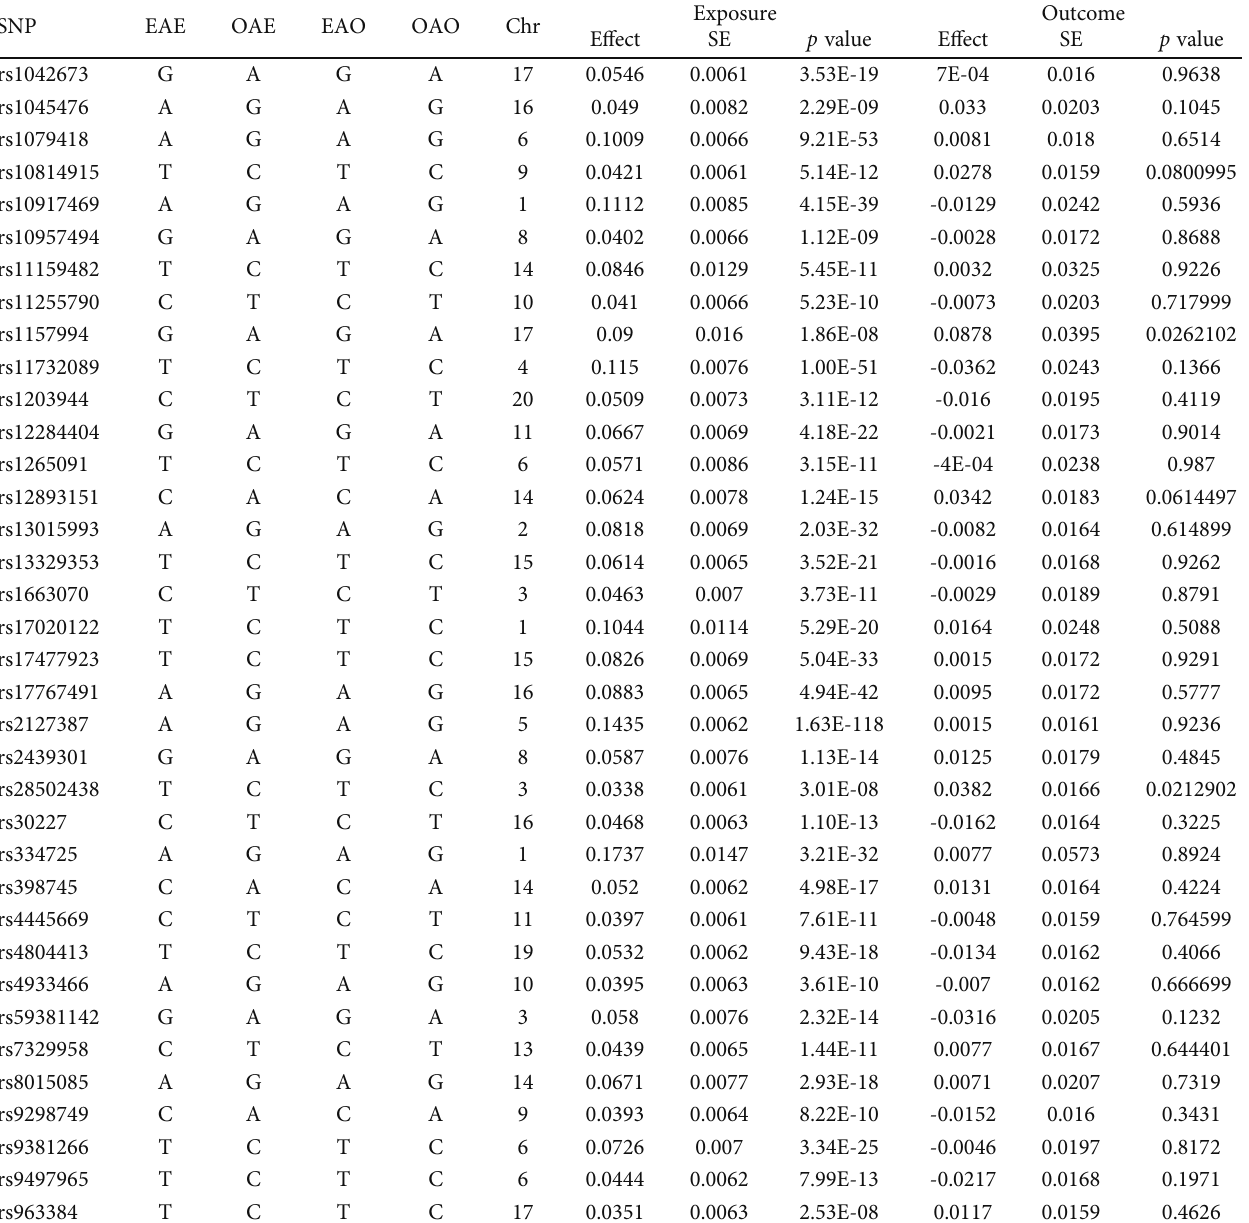
Table 3: Univariate Mendelian randomization analysis for the e ff ects of TSH on venous thromboembolism risk.